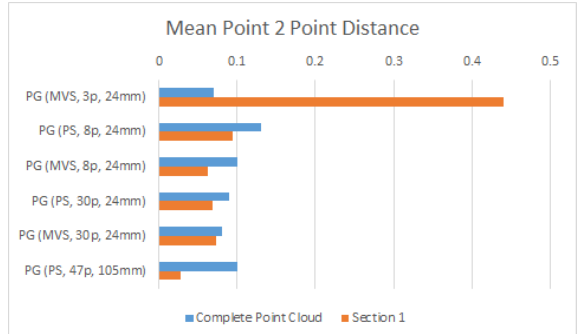
Figure 8. Mean to Point distance between photogrammetric point-clouds and the reference TLS point cloud for different acquisition and processing configurations.